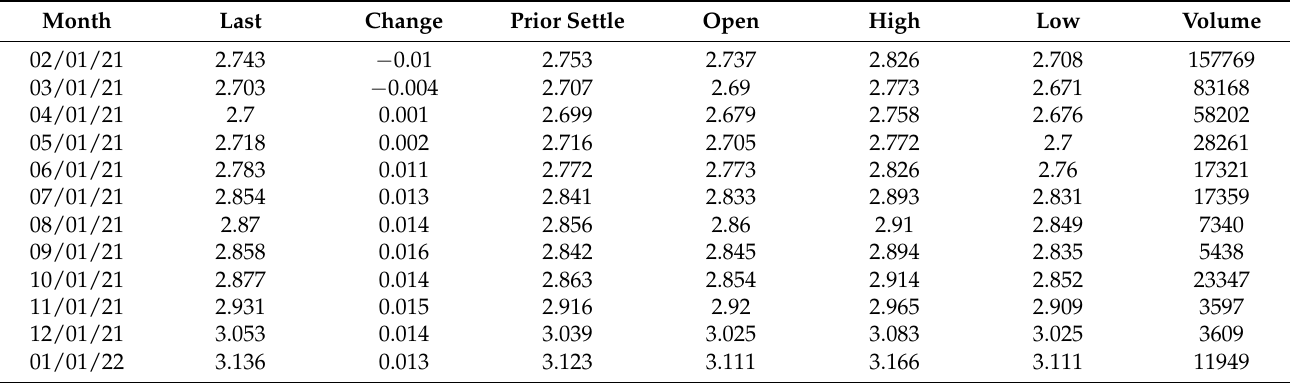
Table 5. CME Futures Prices (per million BTU)